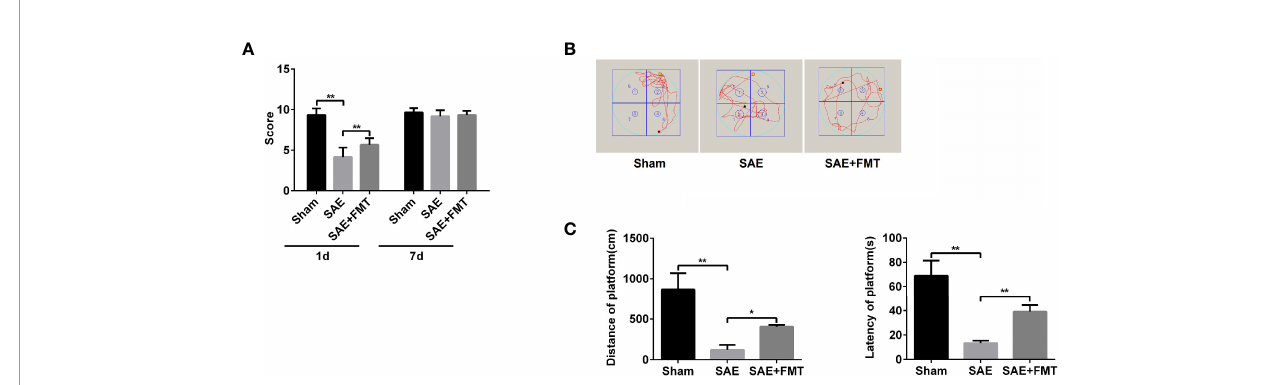
FIGURE 1 | Effects of fecal microbiota transplantation (FMT) on memory impairment of sepsis-associated encephalopathy rats. (A) The rats were processed with Sham control and cecal ligation and puncture surgeries. The sepsis-associated encephalopathy (SAE) rats received control reagent or FMT. Then, the neurologic de fi cit score was measured in the rats of the three groups on day 1 and day 7 after surgery. (B) In the Sham, SAE model, and FMT-challenged SAE rats, Morris water maze was employed to monitor the moving track of rats in the pool. (C) The mobile distance and time percent during platform were recorded and calculated. *P < 0.05. **P <